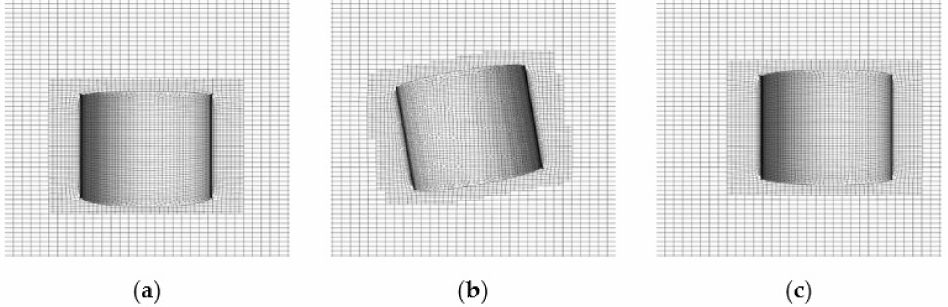
Figure 1. The morphing grid schemes for: ( a ) heave; ( b ) pitch; ( c ) and surge.